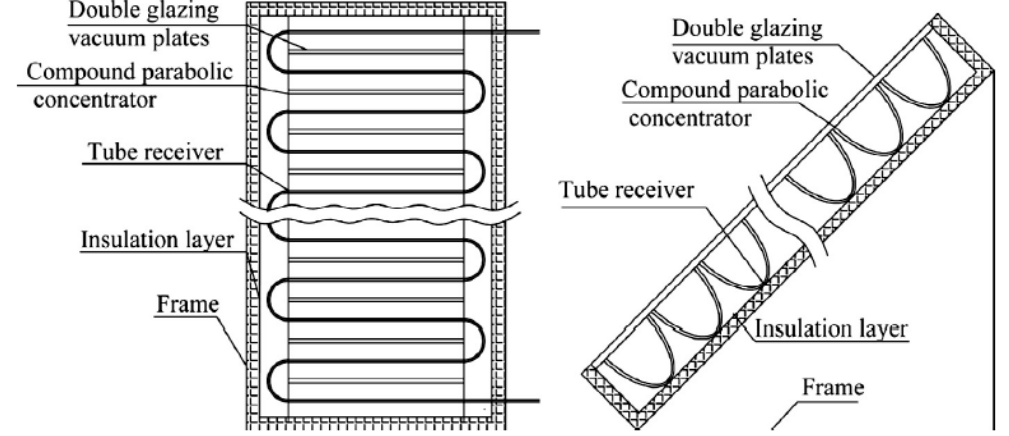
Figure 28. Schematic of the serpentine CPC configuration (left: Front view; right: Section view) [59].